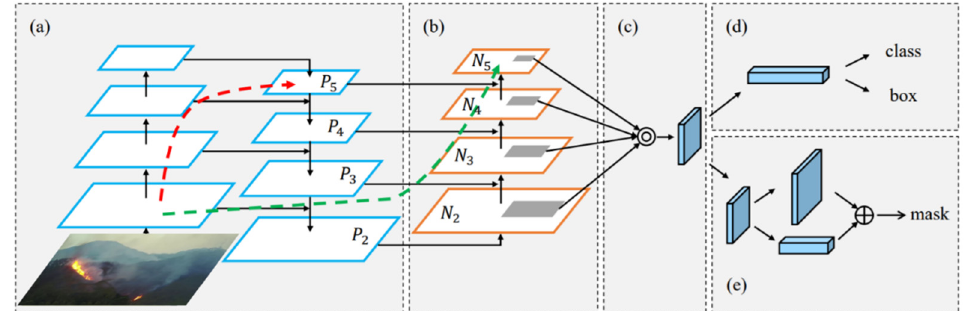
Figure 6. The network architecture of PAFPN. ( a ) is FPN; ( b ) is the bottom-up feature fusion layer added by PAFPN; ( c ) is the adaptive feature pooling layer; ( d ) is the bounding box prediction header of PAFPN; ( e ) is the full connection fusion layer used for prediction mask.